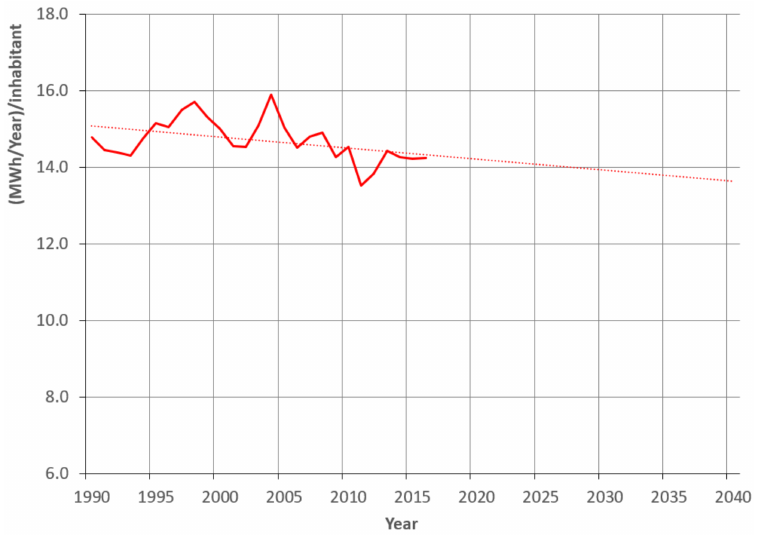
Figure 4. B.C. Road transportation energy use per year per inhabitant, data from